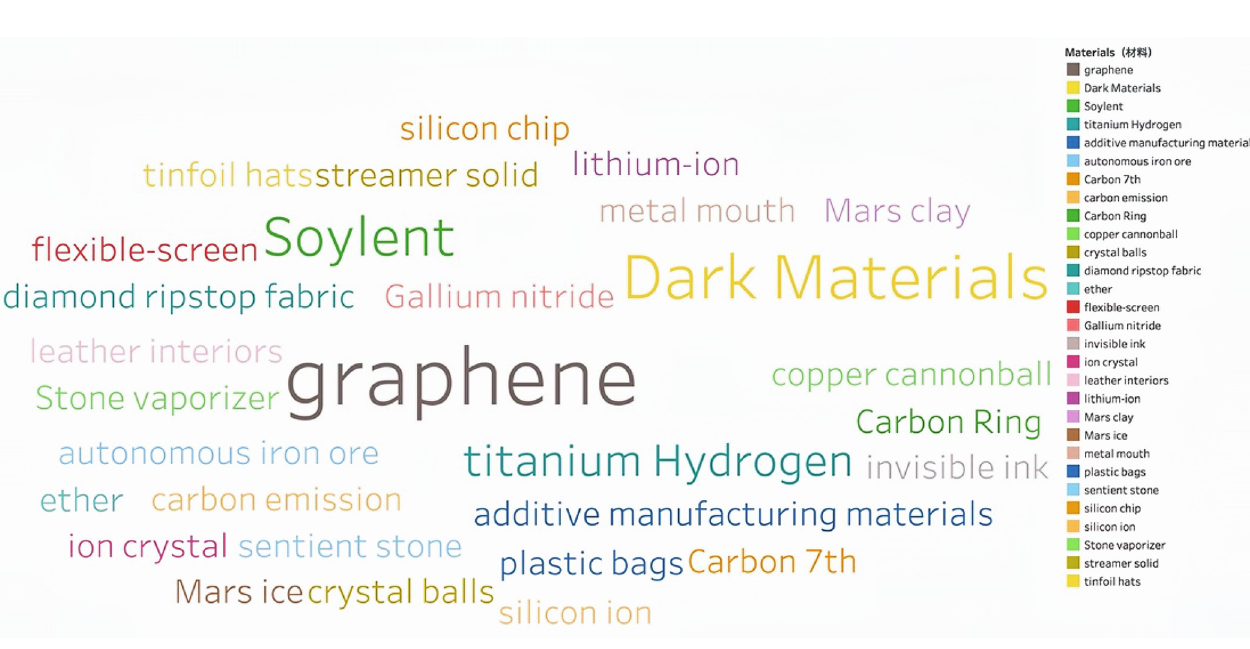
Secondlly, data sorting layer: We clean the crawled data and perform named entity labeling and preprocessing. Thirdly, data storage layer: After cleaning, this layer stores standardized data that can be used for data analysis, such as metadata, model database, collection database.